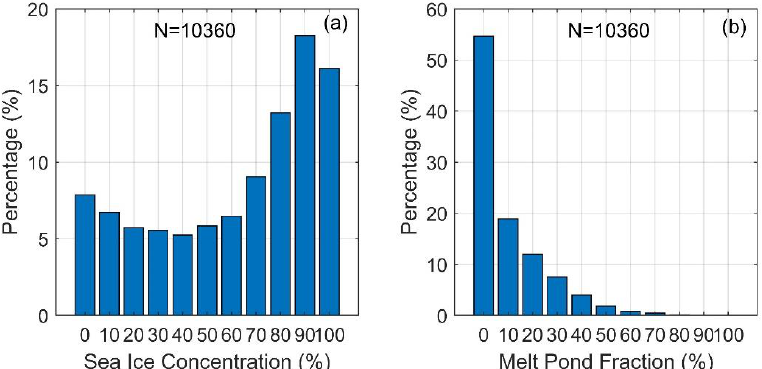
Figure 2. The distribution of the ship-based observed sea ice concentration (SIC) ( a ) and melt pond fraction (MPF) ( b ) values for all 60 cruises.